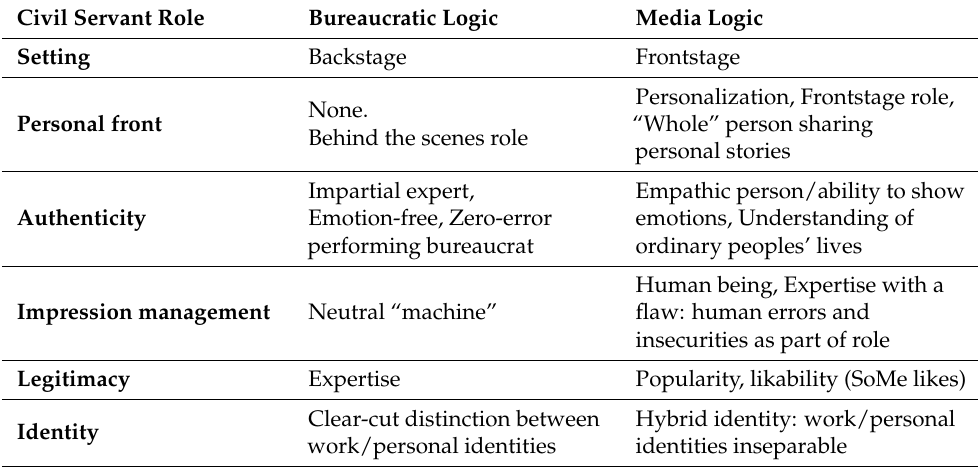
Table 1. The civil servant ideal type role under “bureaucratic logic” and “media